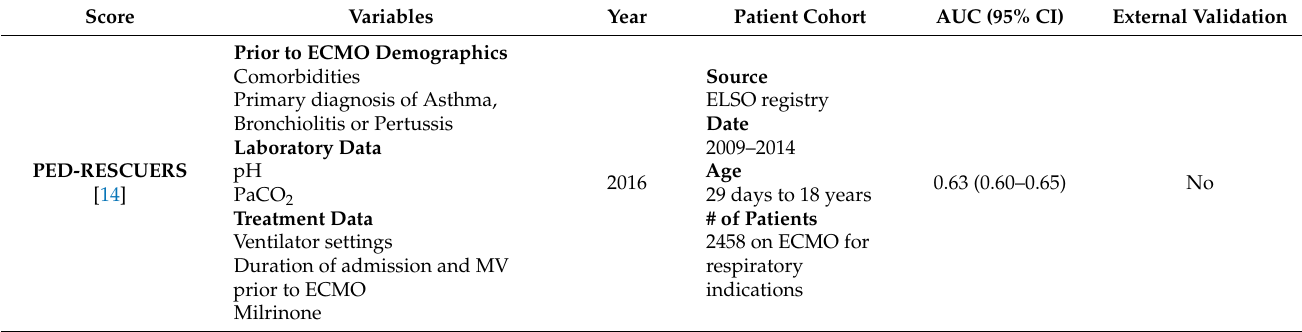
Table 3. Prognostication scores for pediatric respiratory